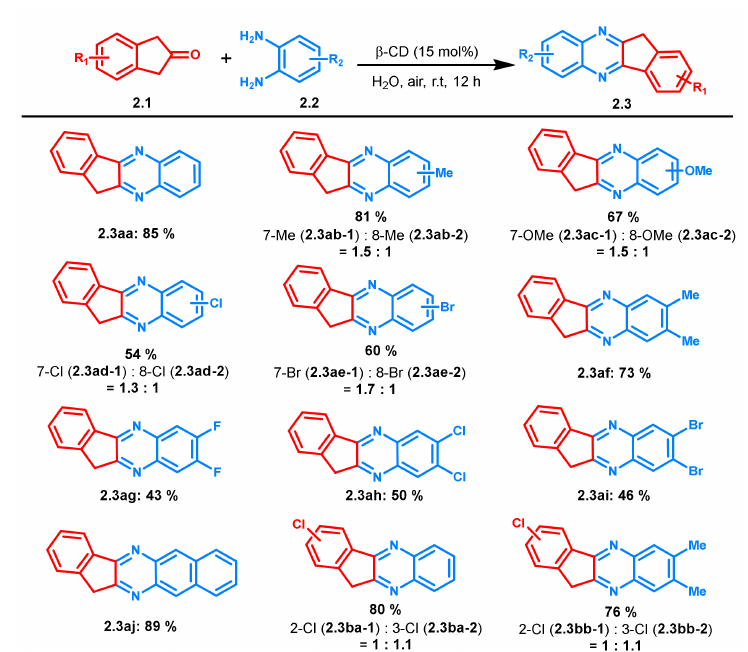
Figure 2. Scope of the various substituted 2-indanones ( 2.1 ) and o-phenylenediamines ( 2.2 ) to